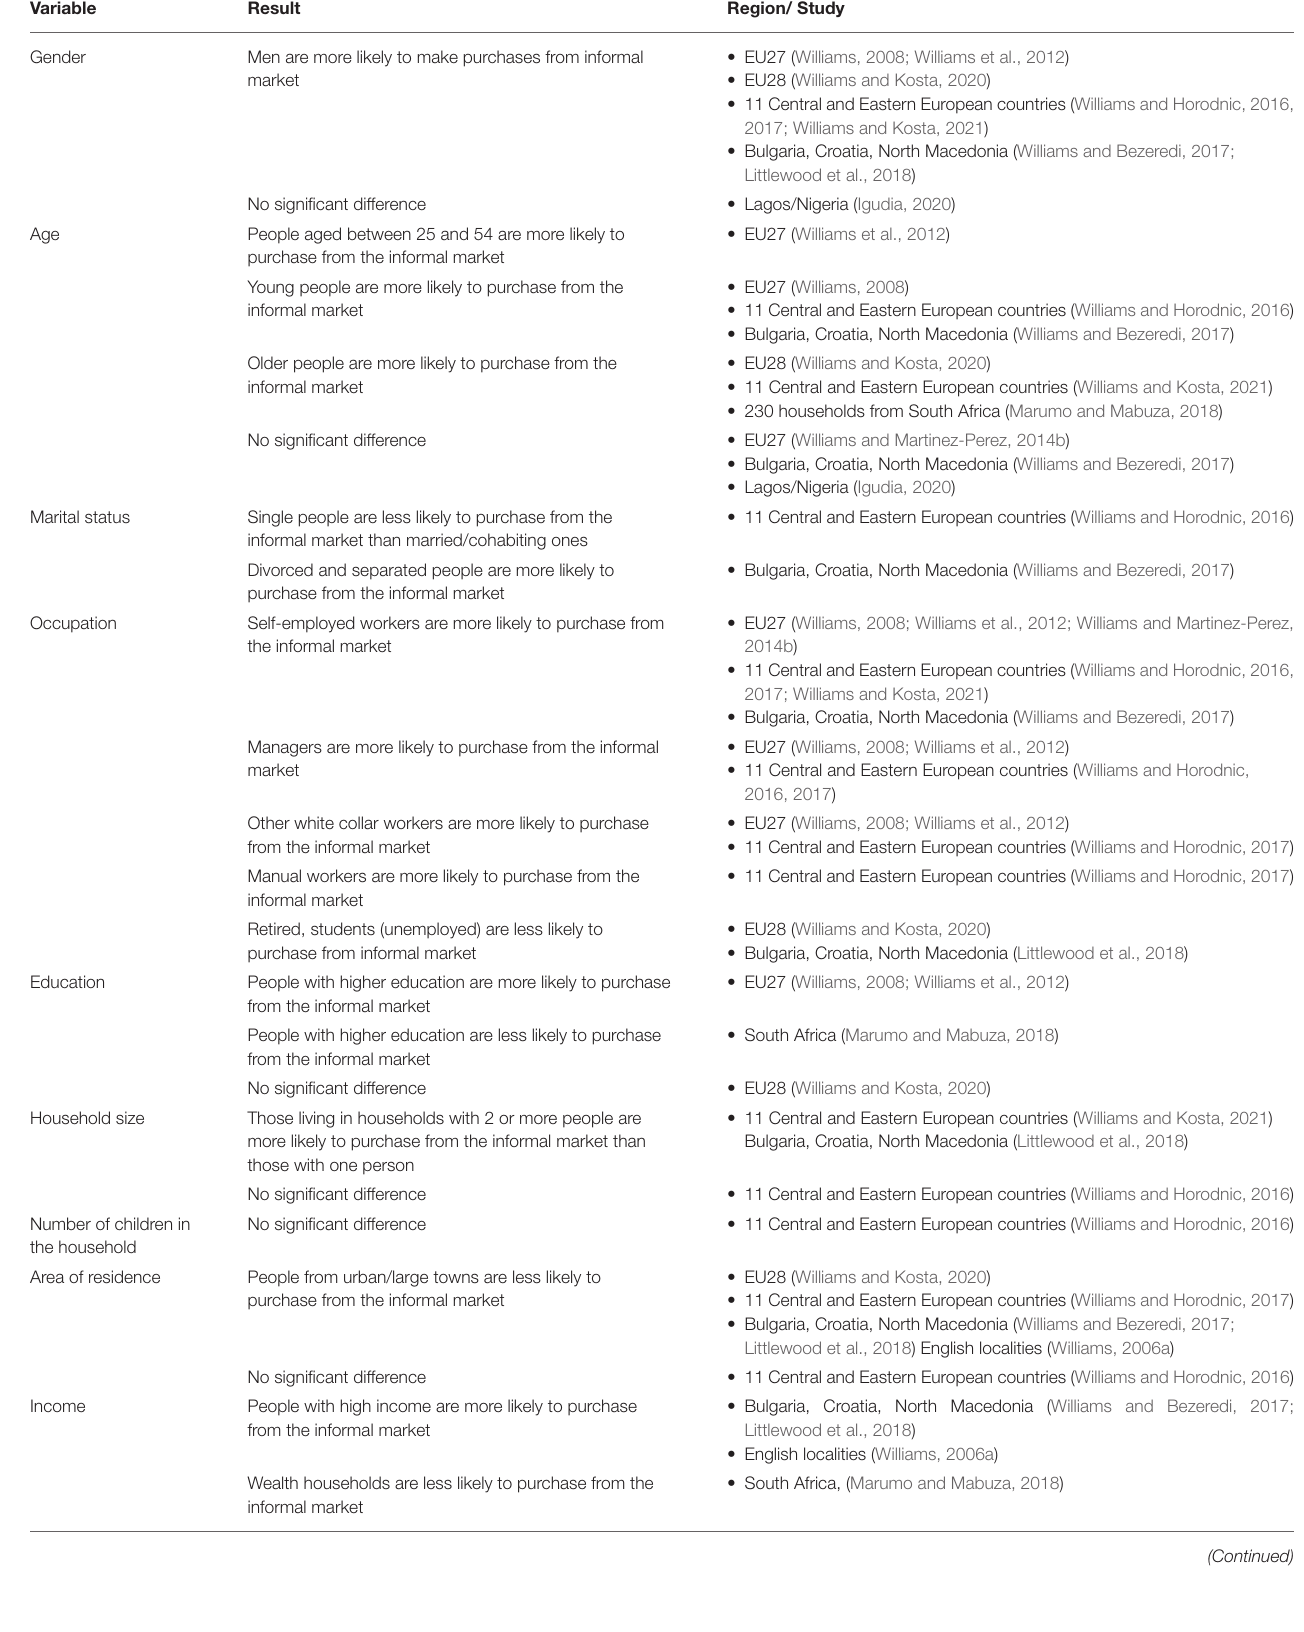
TABLE 1 | Socio-demographic characteristics of the consumer goods and services traded on the informal market.